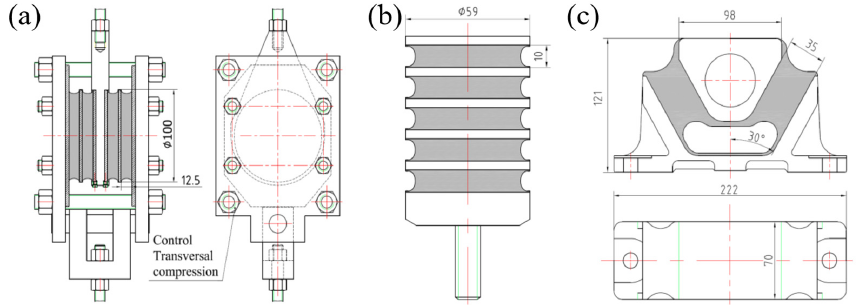
Figure 3. Layouts of rubber spring samples: ( a ) ST, ( b ) CT and ( c ) SCCT.